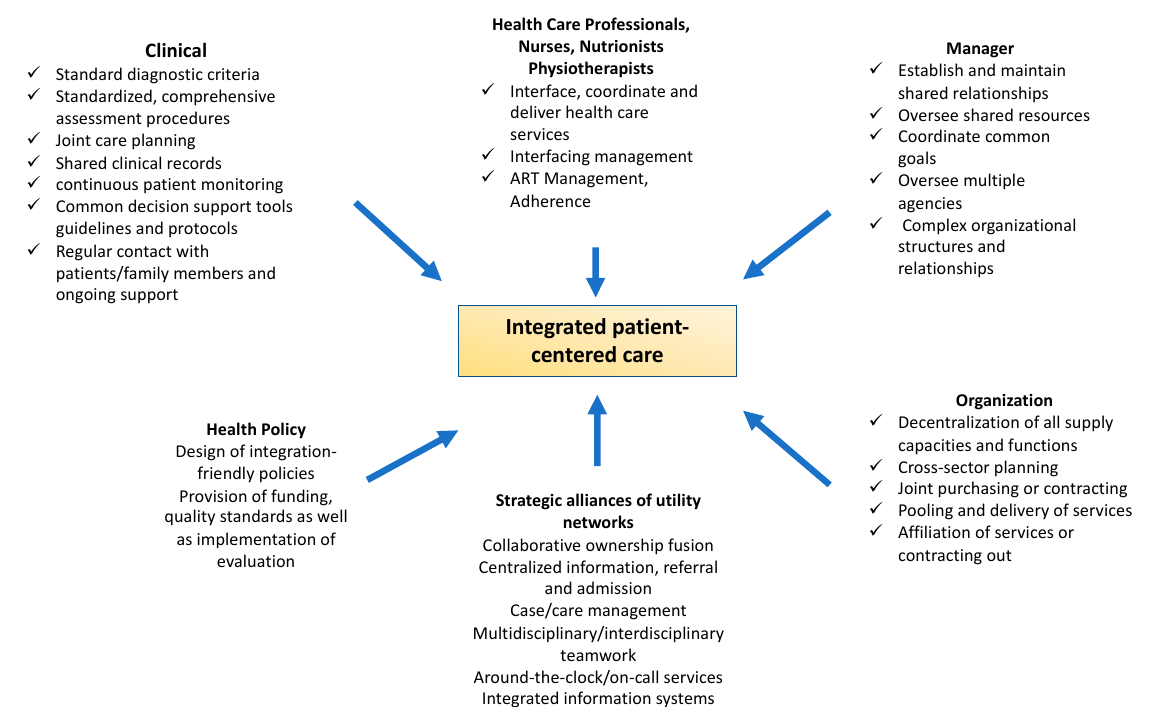
Figure 1. Model of integrated care (own presentation; data from the (WHO) [33].